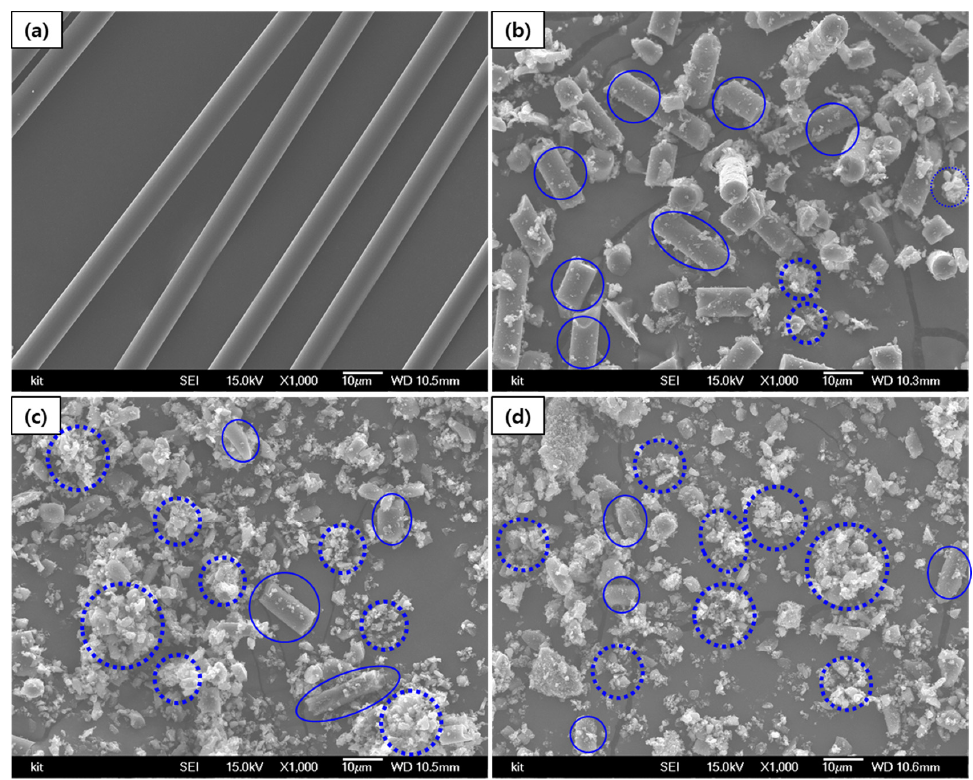
Figure 1. SEM images of mPCFs (×1000). ( a ) Desized carbon fiber and ball milling times of ( b ) 6 h, ( c ) 12 h, and ( d ) 18 h.